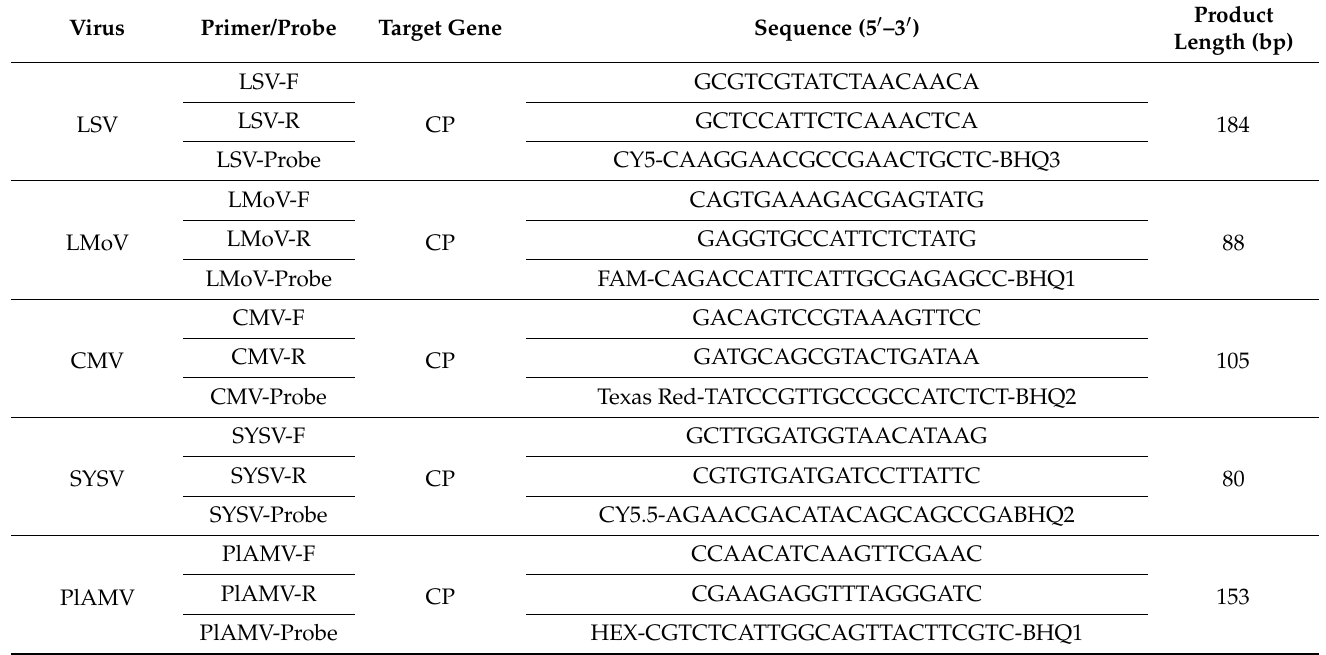
Table 1. Primers and probes used in this